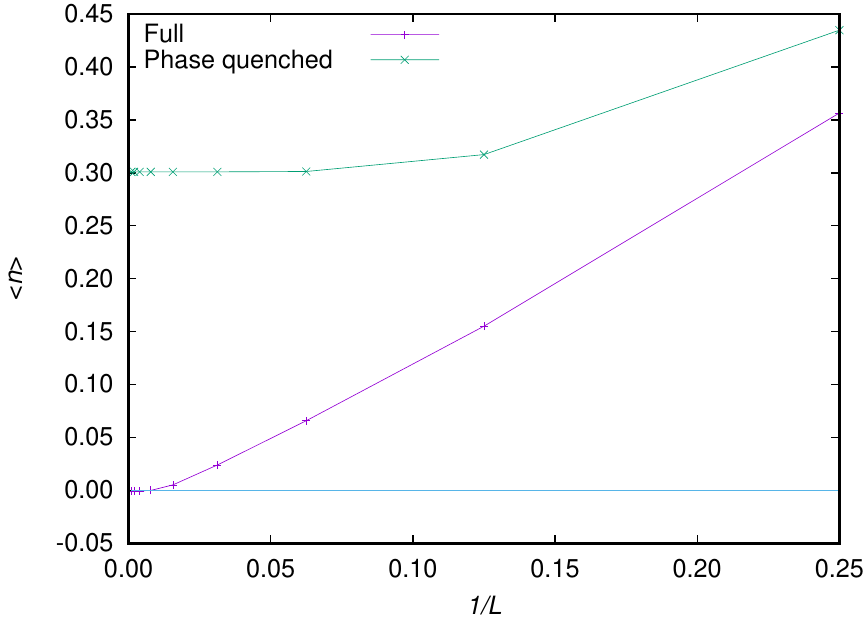
Figure 6 . h n i as a function of 1 =L at (cid:22) = 0 : 904, m 2 = 0 : 01, (cid:21) = 1, K = D = 64. The density for the phase quenched case converges to a non-zero value while that for the full theory converges to zero in the thermodynamic limit.